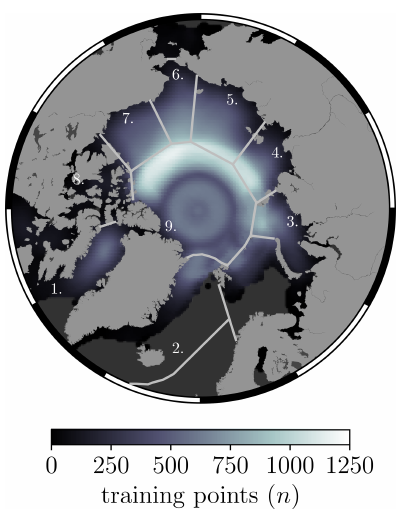
Figure 8. The number of training points used to predict radar free- board at each grid cell at 50 × 50km resolution, shown as an aver- age across all days between the 1 December 2018 and the 24 April 2019. The contour lines mark the boundaries between the nine NSIDC regions: (1) Baffin and Hudson bays, (2) Greenland, Ice- land, and Norwegian (GIN) seas, (3) Kara Sea, (4) Laptev Sea, (5) East Siberian Sea (ESS), (6) Chukchi Sea, (7) Beaufort Sea, (8) Canadian Archipelago (CAA), (9) central